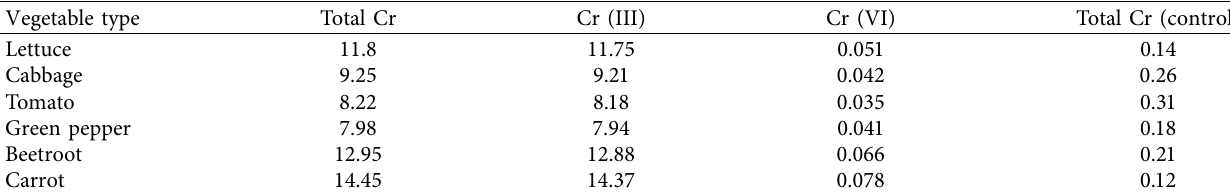
Table 4: Chromium concentration in edible parts of plants from tannery-contaminated area [mg kg − 1 mean ± SD, n � 3]. Vegetable